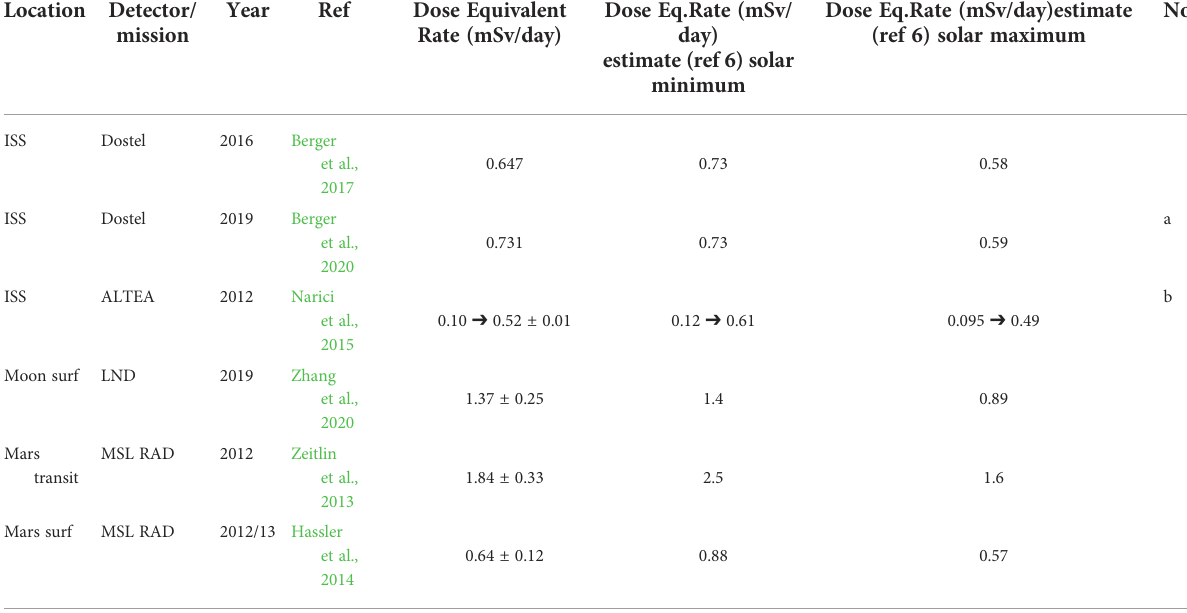
TABLE 1 Radiation measures in several relevant astronomical sites in recent years. Location Detector/